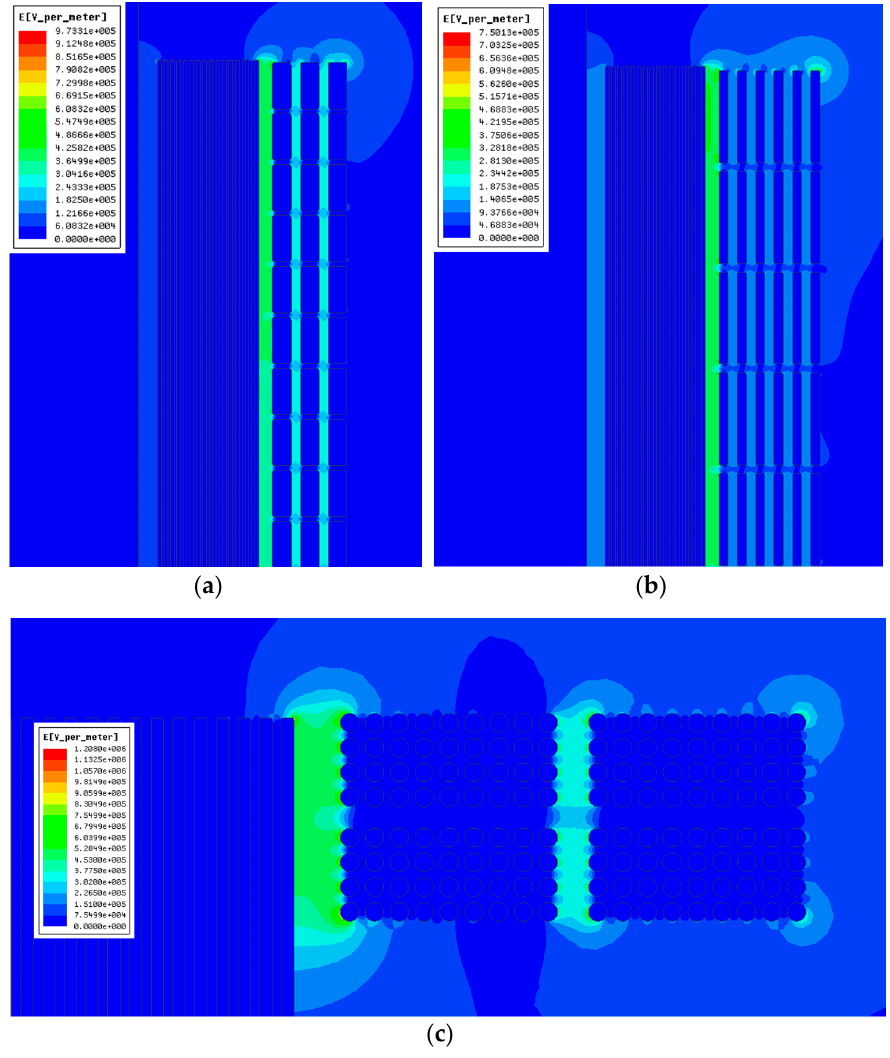
Figure 5. Electric field distribution for different windings: ( a ) N-1; ( b ) N-2; ( c ) N-3.